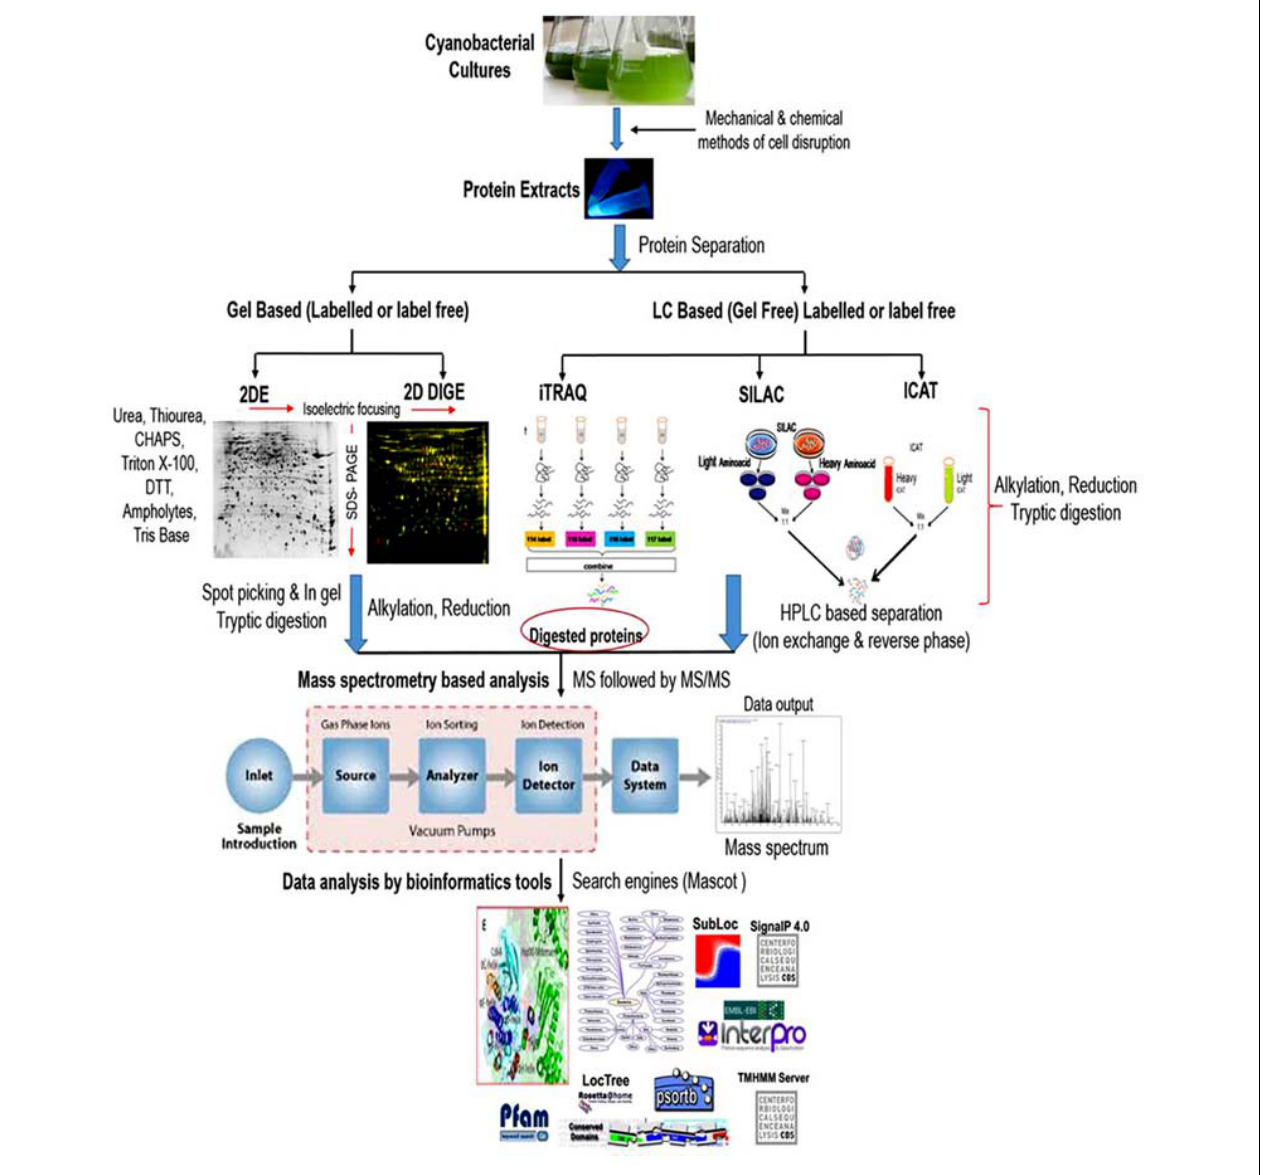
FIGURE 2 | A typical workflow of comparative proteomic analysis in cyanobacteria. Proteins are extracted, cleaned and subjected to separation via gel (2-Dimensional gel electrophoresis) or non-gel (liquid chromatography) based approaches. Reduction, alkylation and trypsin digestion are performed before or after the separation step as per the requirement to convert protein mixtures into peptides. Separated peptides are analyzed through mass spectrometer (MS) followed by tandem MS (MS/MS) for the protein identification. The detected protein list is then used for data analysis using various bioinformatic